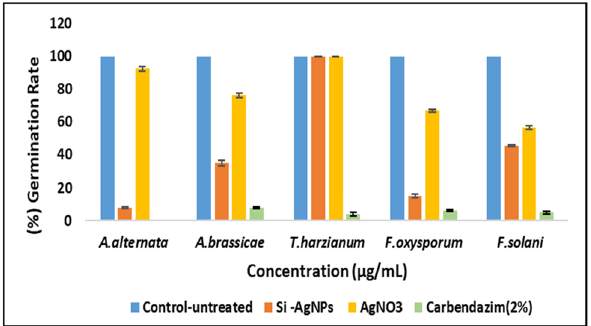
Figure 10: The e ff ect of the biosynthesized Si - AgNPs on spore germination of fungal test isolates at 80 µg · mL − 1